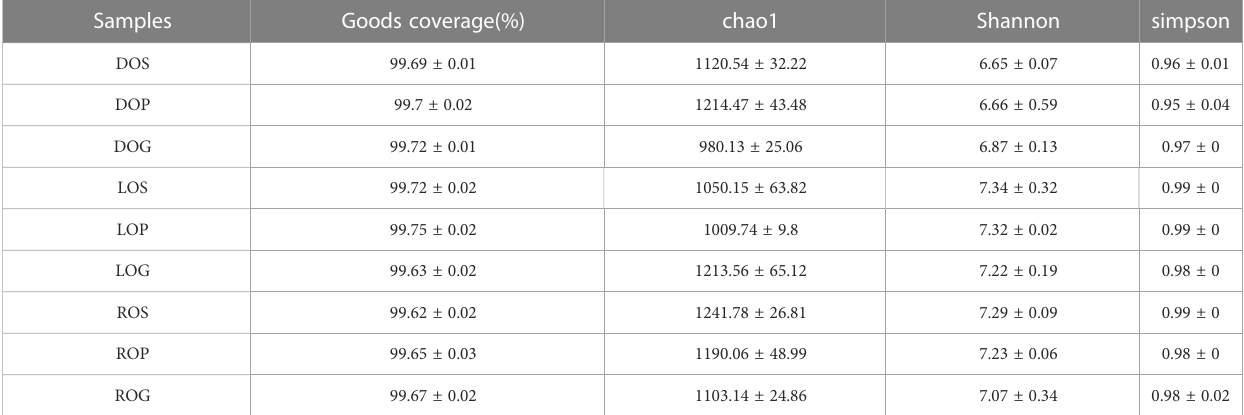
TABLE 3 Gastrointestinal fl ora sequencing quality and alpha diversity.